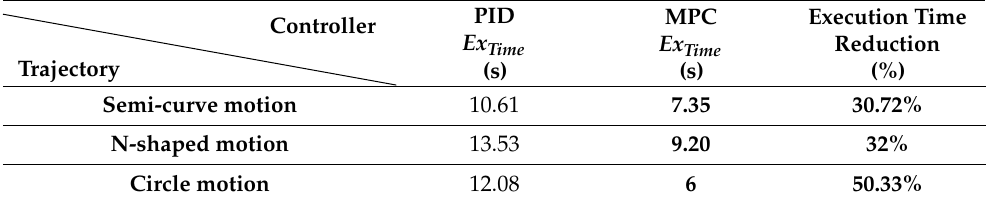
Table 11. Execution time parameter related to the three